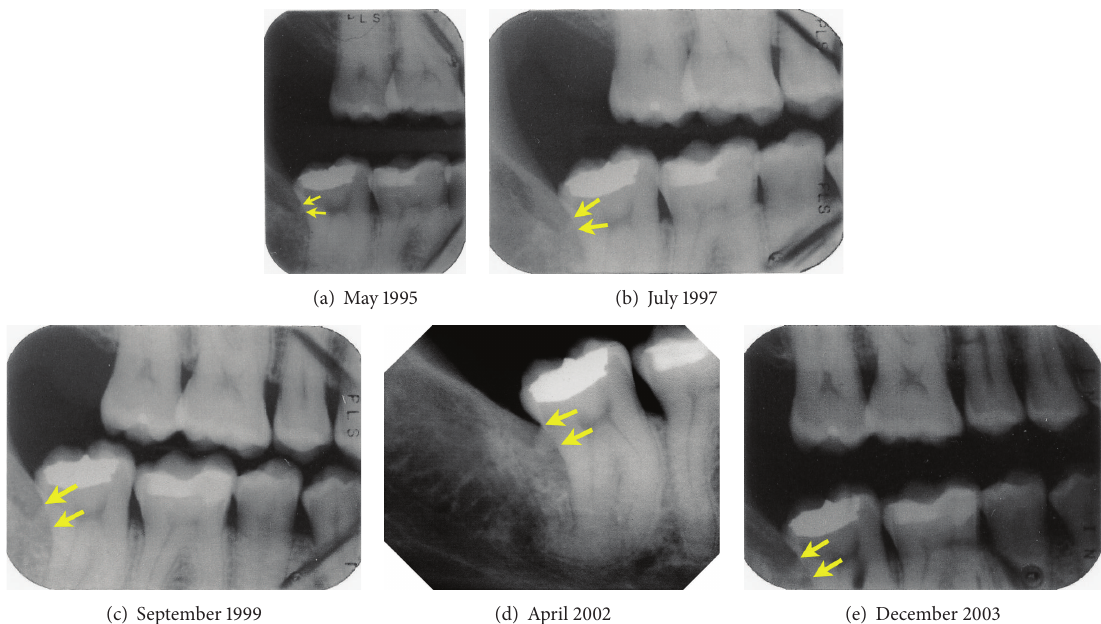
Figure 2: Radiographs of the right molars, taken approximately 13 years (a), 11 years (b), 9 years (c), 6 years (d), and 4.5 years (e) prior to periodontal treatment. The apical and occlusal borders of the calculus are indicated by